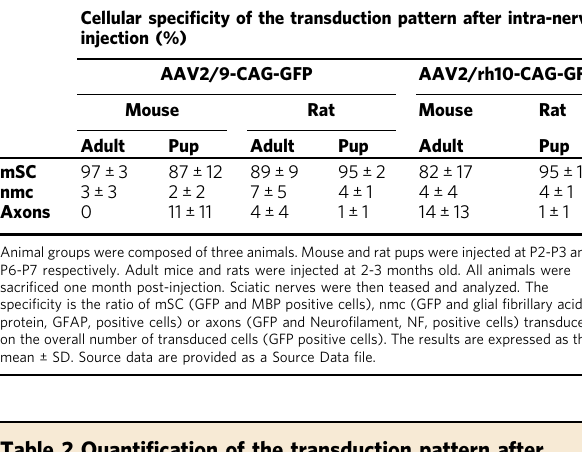
Table 2 Quanti fi cation of the transduction pattern after in